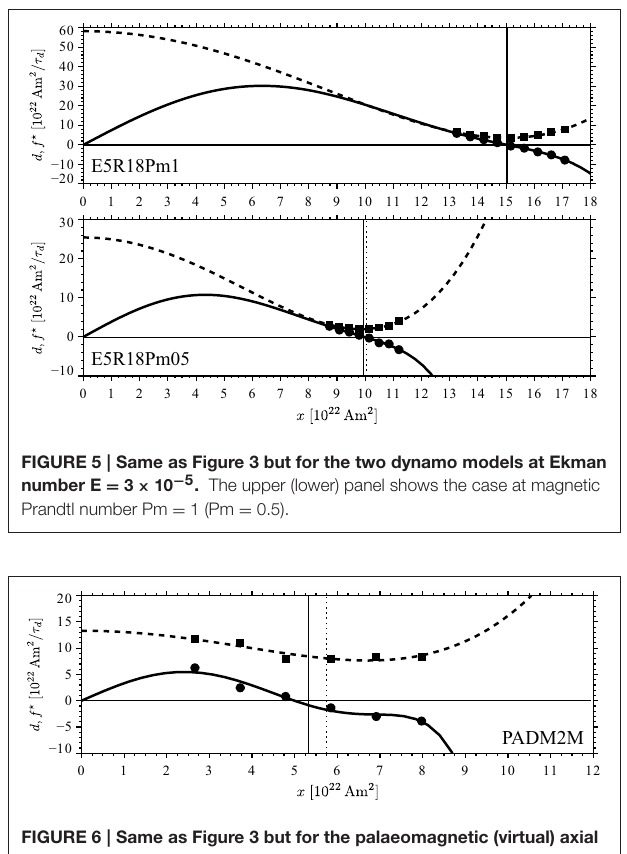
FIGURE 4 | Same as Figure 3 but for the four dynamo models at Ekman number E = 3 × 10 − 4 .